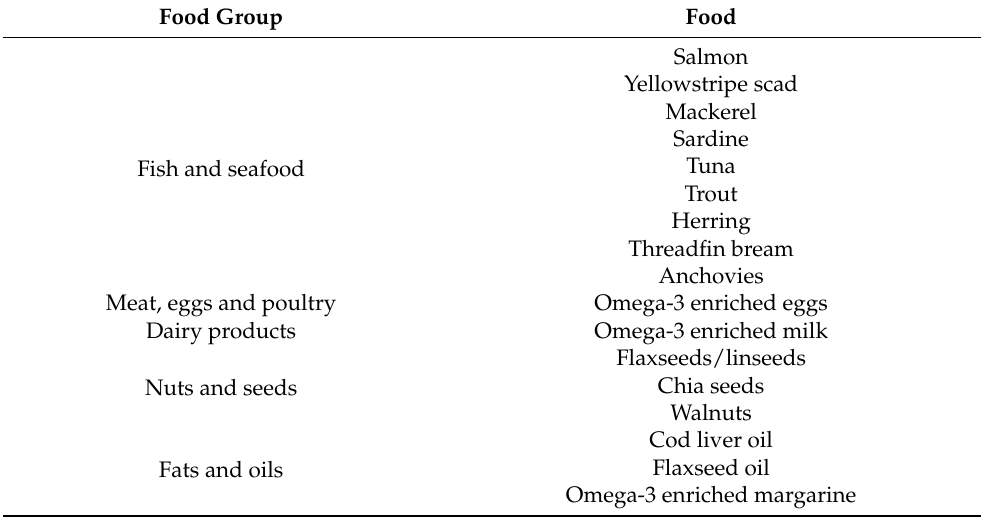
Table 2. List of omega-3 rich